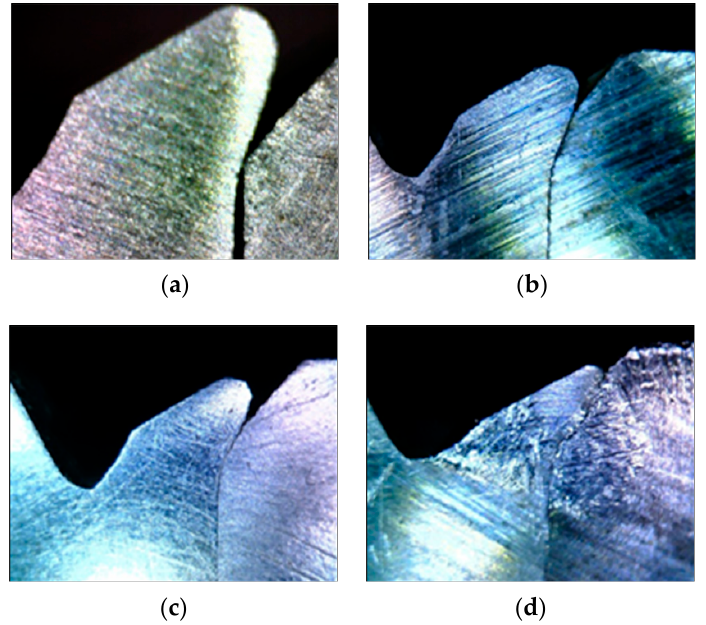
Figure 12. Cross-sectional view and state comparison of specimens under MSCL control and displacement–time control: ( a ) initial deformation controlled by MSCL; ( b ) “State 2” of MSCL; ( c ) “State 3” of MSCL; ( d ) “State 5” of displacement–time control.